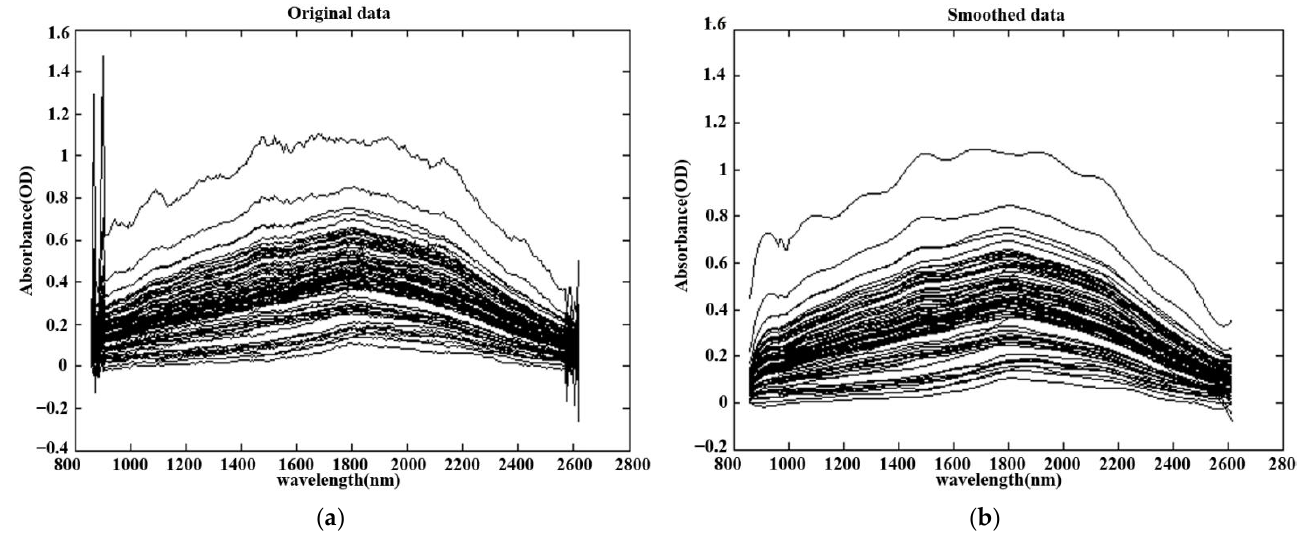
Figure 12. ( a ) Original data graph. ( b ) Smoothed data graph.